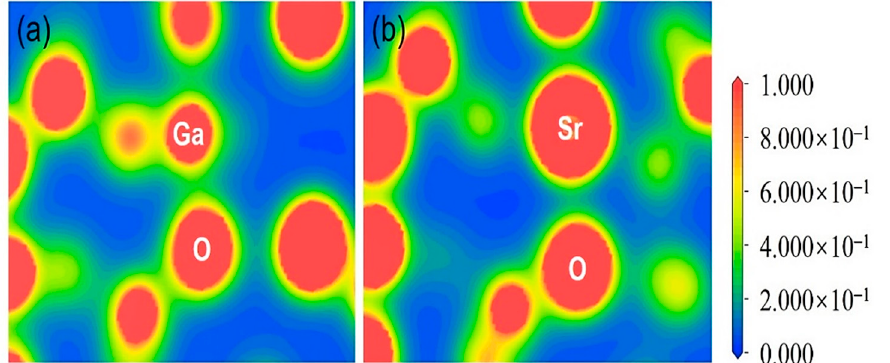
Figure 3. Distribution of electron density of ( a ) pure β -Ga 2 O 3 and ( b ) Sr-doped β -Ga 2 O 3 .